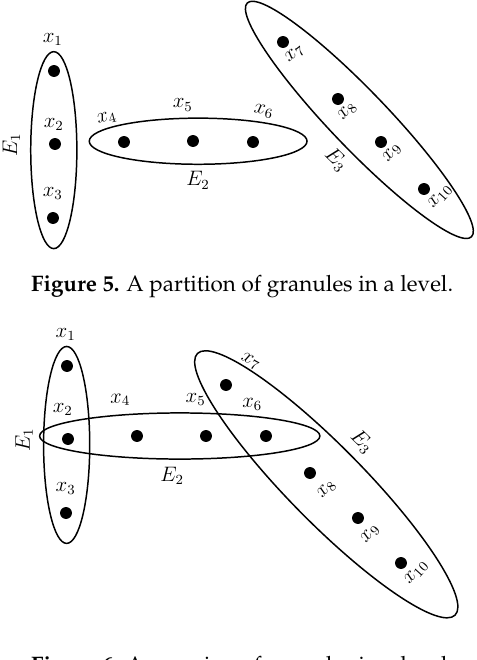
Figure 6. A covering of granules in a